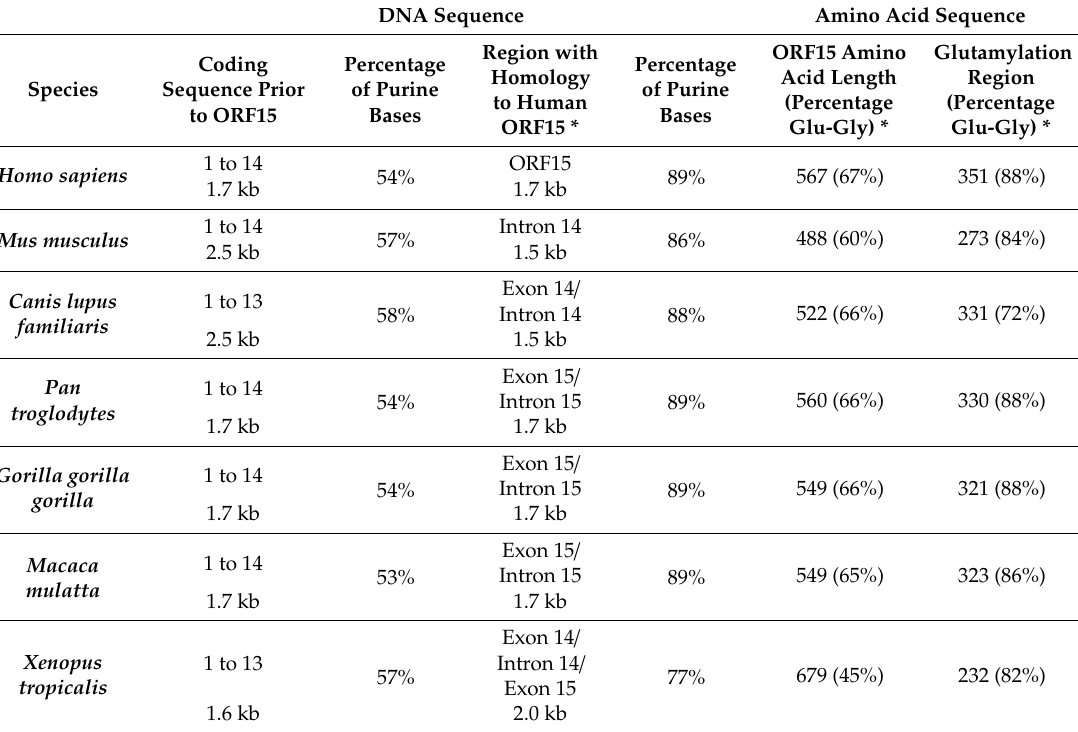
Table 1. Evolutionary conservation of DNA and amino acid sequences of RPGR ORF15 variants across selected species. All data were extracted from NCBI database files with comparisons performed in Geneious Prime 2017.10.2. For Homo sapiens , details were extracted from gene files NG_009553.1 and 6103 combined with mRNA file NM_001034853.2. * The conserved basic domain of the human RPGR ORF15 coding sequence was used for predictions of ORF15 locations in all other species sequences by homology alignment. For Mus musculus data, gene files NC_000086.7 and 19893 were aligned with the basic domain of human RPGR ORF15 and the partial sequence file AF286473.1 to identify the predicted ORF15 variant. For Canis lupus familiaris data, gene files 403726 and AF148801.1 were aligned with the basic domain of human RPGR ORF15 and the partial sequence file AF385629.1. For Pan troglodytes data, files 4465569 and XM_024352988 were used. For Gorilla gorilla gorilla , files 101149059, the basic domain of human RPGR ORF15 and the partial sequence AY855163.1 were combined. For Macaca mulatta , files 714316, the basic domain of human RPGR ORF15 and the partial sequence file AY855162.1 were combined. Finally, Xenopus tropicalis sequence predictions were achieved from files 733454 and